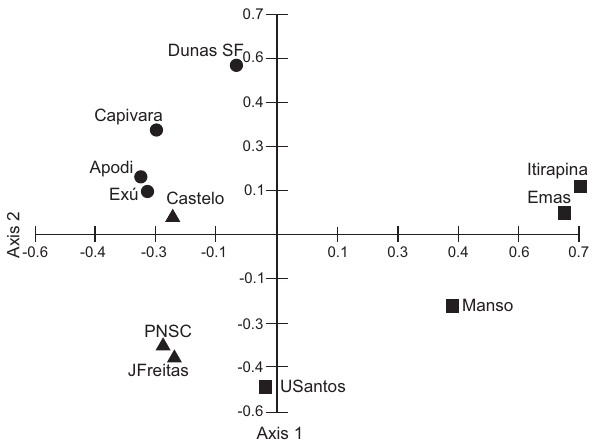
Figure 10. Ordination diagram of the Principal Coordinates Analy- sis (PCoA) resulting from the species composition of thirteen lo- calities. Axis 1: eigenvalue = 1.57 and 21.9% variance, axis 2: eigen- value = 1.05 and 14.6% variance. Legends: Cerrado (squares), transition area (triangles) and Caatinga localities